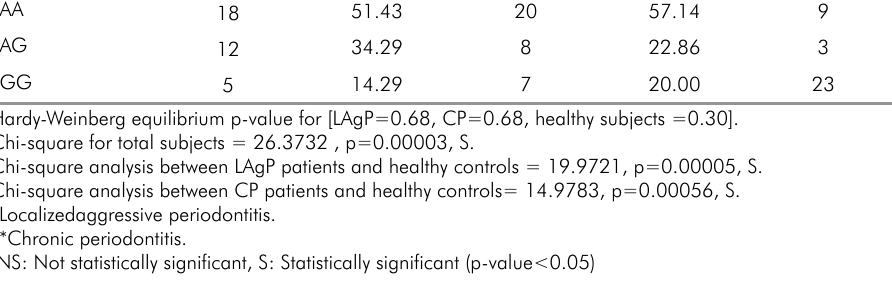
Table 3. Distribution of study subjects according to genotype and study groups.